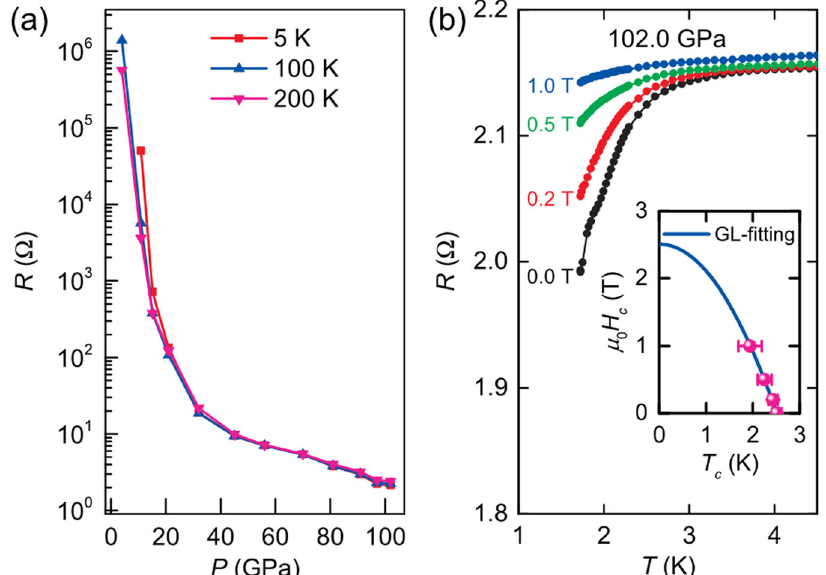
Fig. 6 a Isothermal resistance at various pressures on a semi-logarithmic scale at 5, 100, and 200 K, respectively. b Magnetic fi eld dependence of the resistance drop in ReS 2 at 102.0 GPa. The inset shows the temperature dependence of the upper critical fi eld μ 0 H c2 at 102.0 GPa. Here T c at different magnetic fi elds is determined by the crossing of two lines. The solid line represents the fi tting curves based on the Ginzburg – Landau (GL)